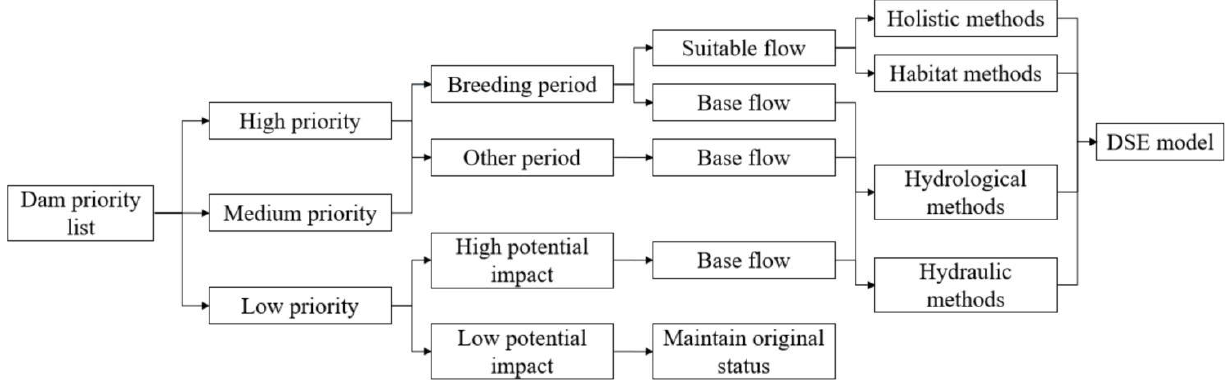
Figure 1. Working program for creating different e-flow scenarios.